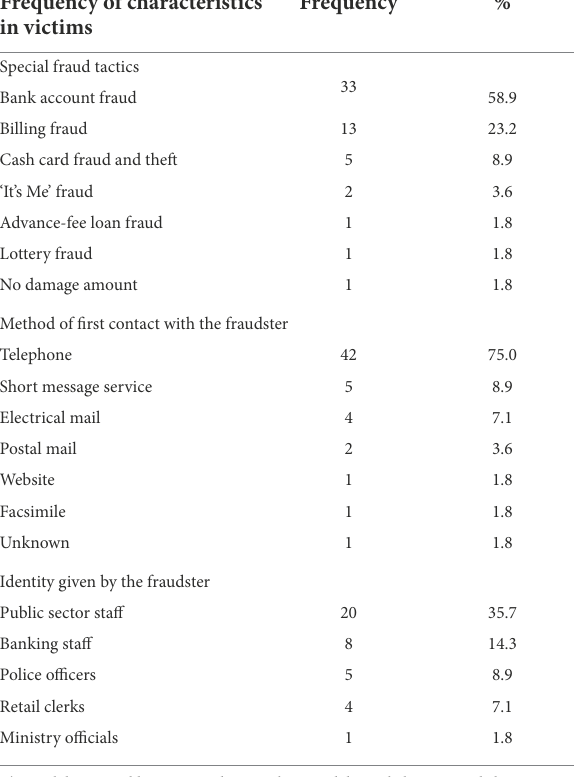
TABLE 2 Frequency of the special fraud tactics; the method of first contact with the fraudster; the identity given by the fraudster to